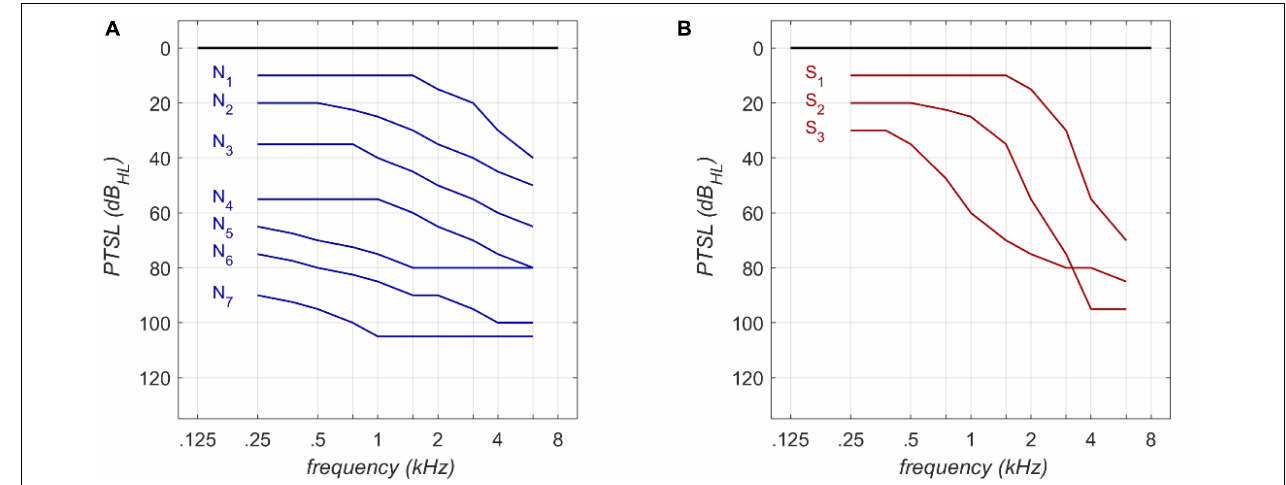
FIGURE 1 | Audiogram types according to Bisgaard et al. (2010) for flat (A) and steep (B) audiograms.